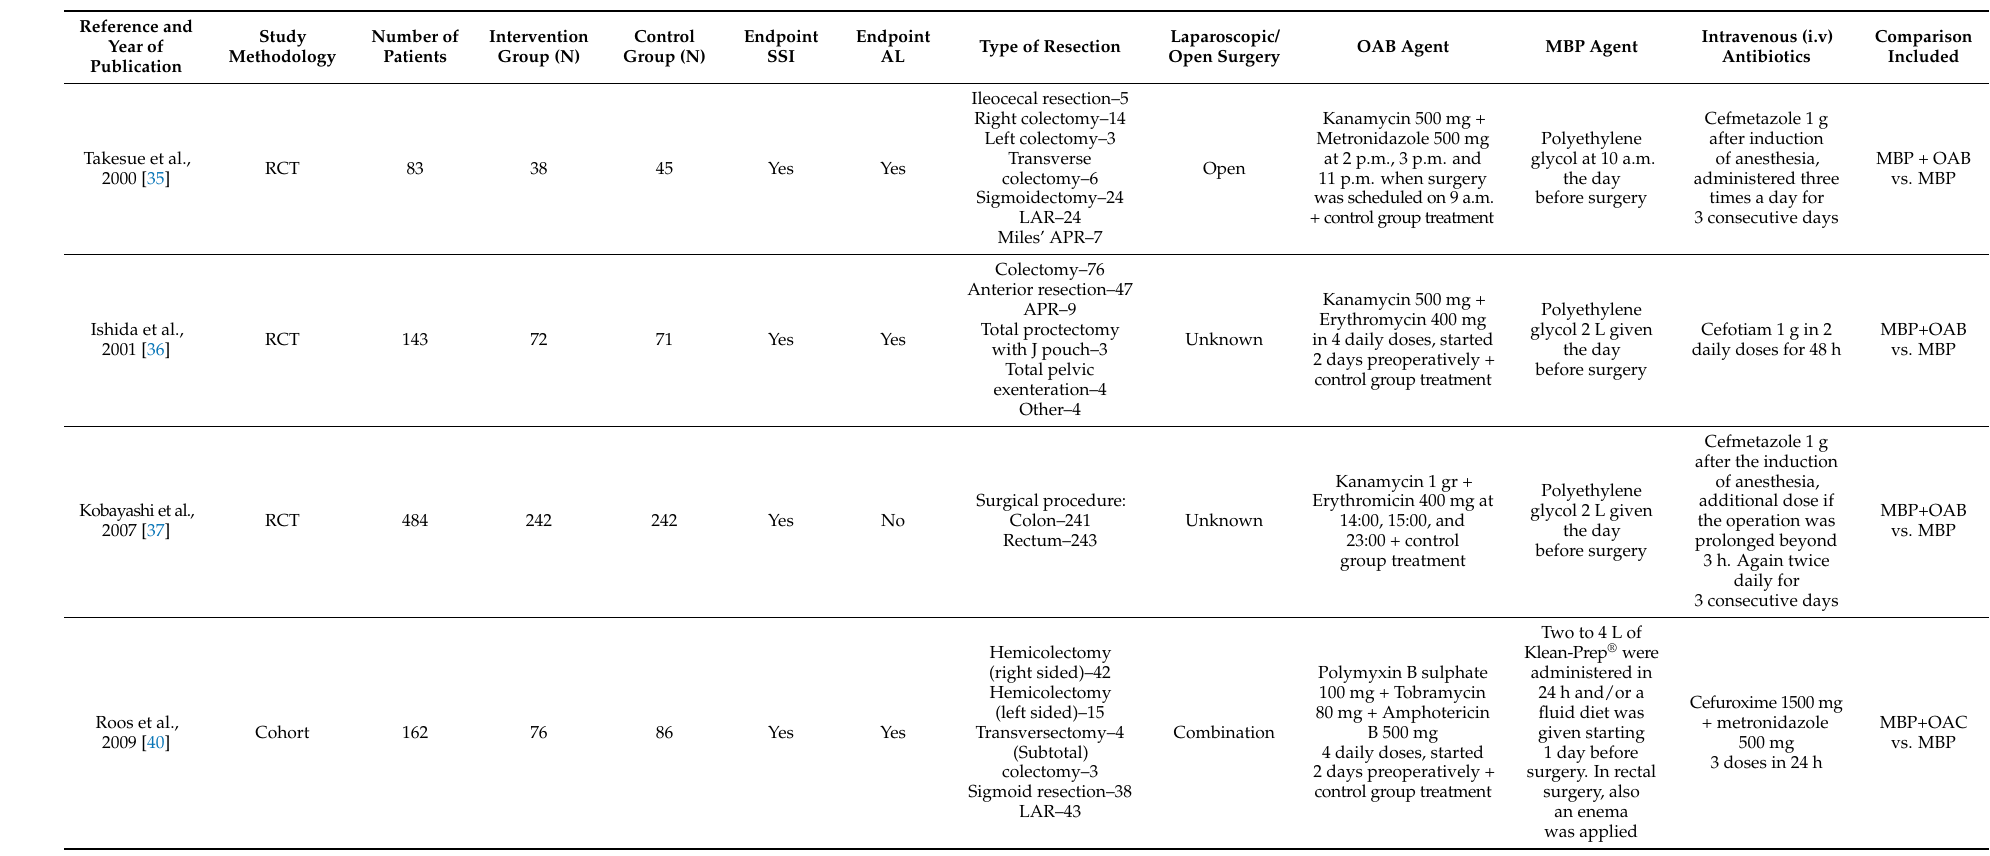
Table 1. Baseline characteristics per